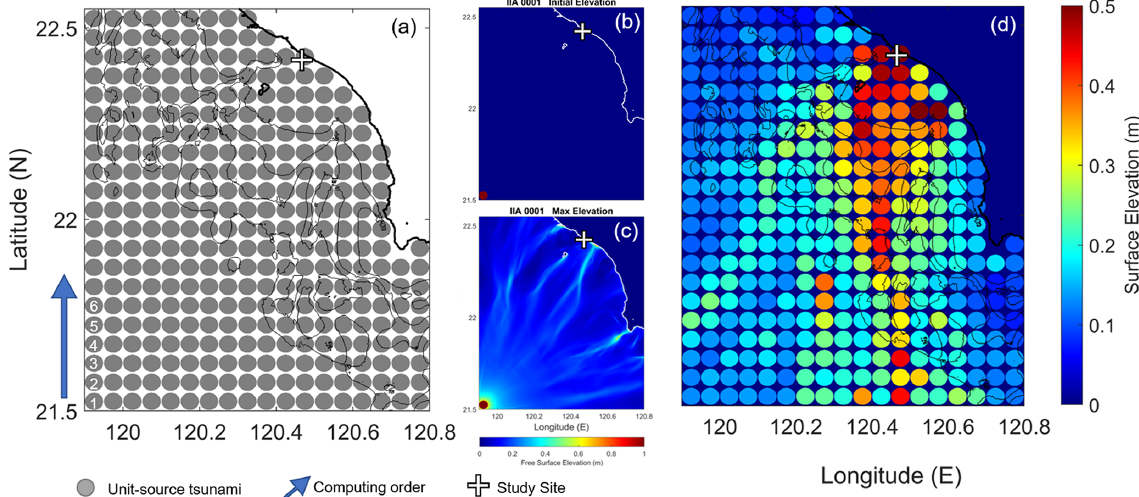
Figure 2. IIA method procedure. (a) Unit-source tsunamis are set in the discretized domain of the numerical simulation and conducted individually. (b, c) The results of the first unit-source tsunami are presented here as an example. The initial elevation (b) and the maximum wave height (c) are the essential data that should be saved for each simulation. (d) Each simulation’s source location is colored by the maximum wave height recorded at the study site (marked by the white cross). Together they form a map comparing the impact of tsunamis in the study